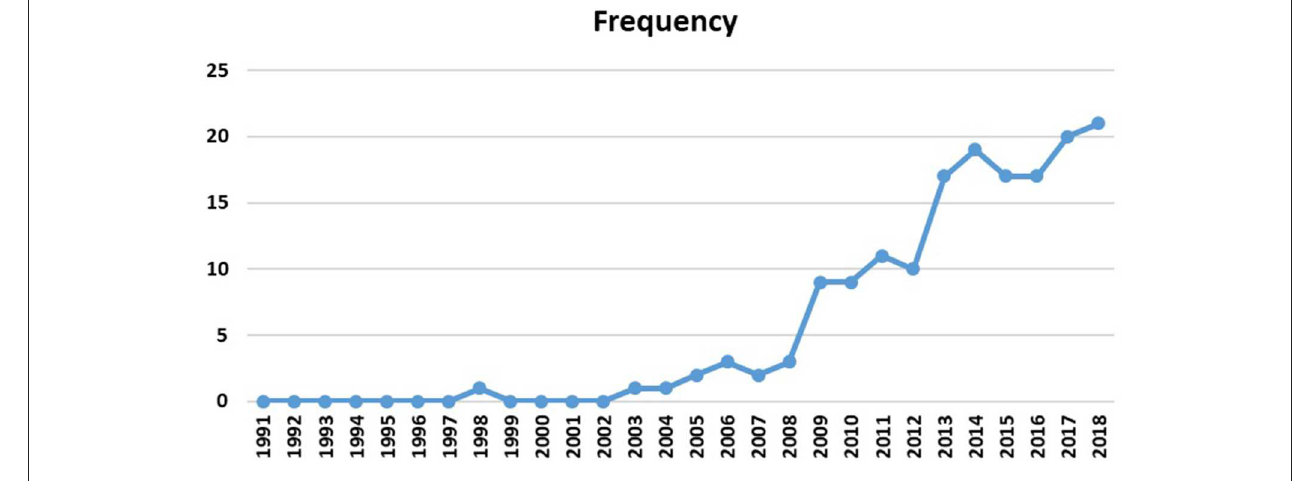
FIGURE 9 | Selected papers per year (publishing trend).